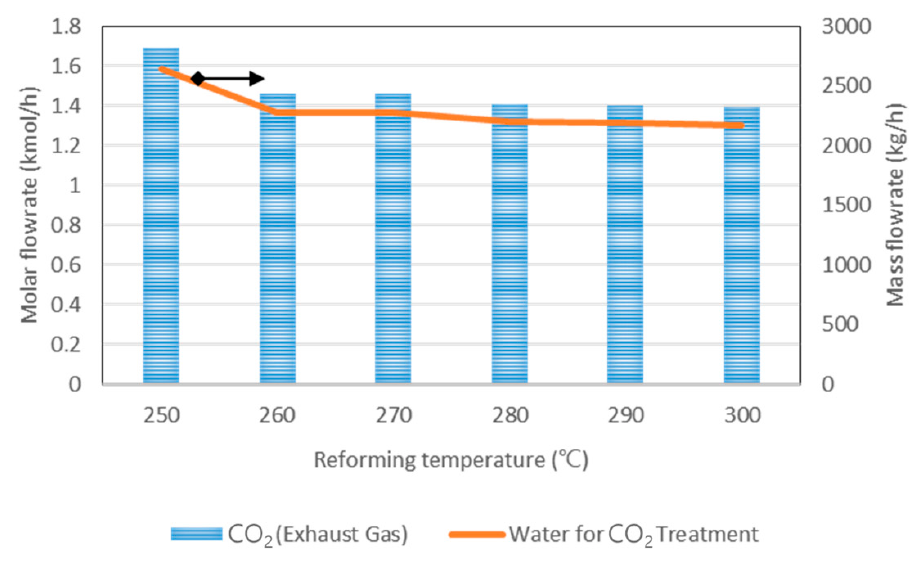
Figure 10. E ff ect of reforming temperature on CO 2 generated and water to solve CO 2. Figure 10. Effect of reforming temperature on CO 2 generated and water to solve CO 2.